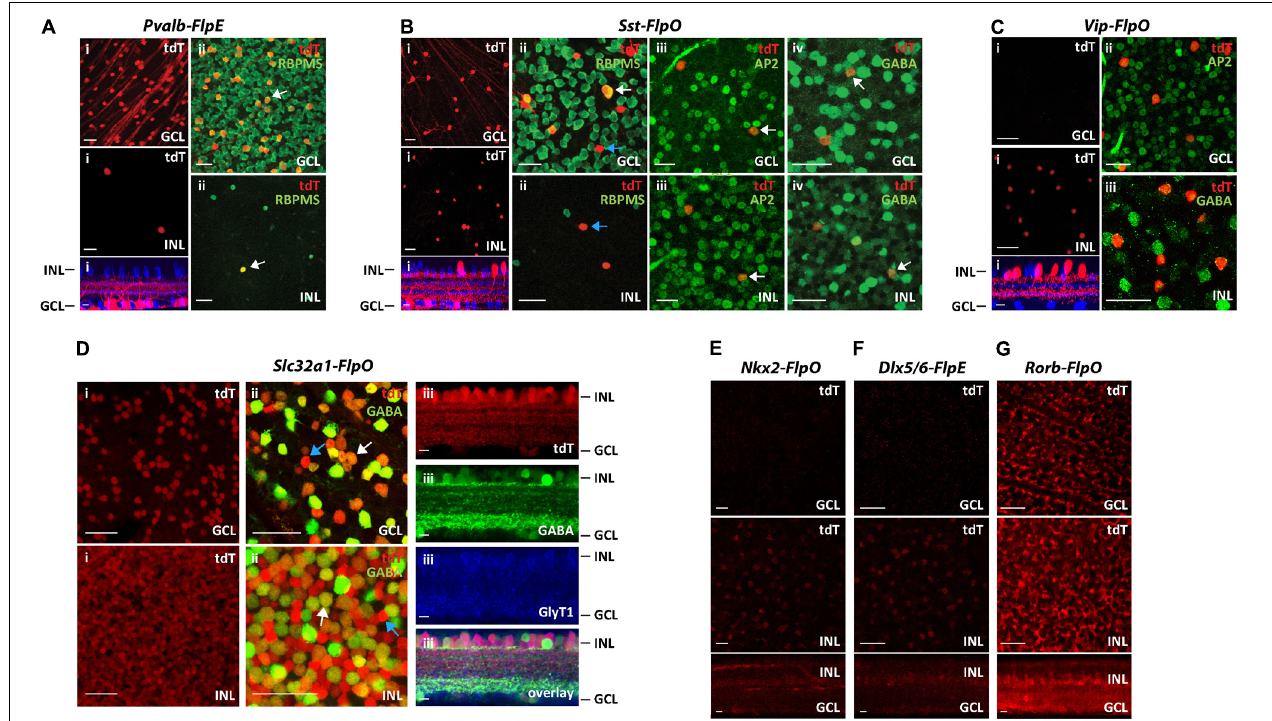
FIGURE 2 | Distribution of FLP-expressing cells in 7 Flp drivers. Each Flp driver was crossed with CMV-Cre and Ai65 mice. (A) Pvalb-FlpE driver. (i) FLPe expressing cells labeled with tdTomato (tdT, red) were observed in the GCL (top) with only a few cells in the INL (middle). Bottom: side view with ChAT (blue). (ii) Staining for the RGC marker RBPMS (green) confirmed that all of the tdTomato-labeled cells (tdT, red) in the GCL and the INL were RGCs. White arrows point to example cells that express RBPMS. (B) Sst-FlpO driver. (i) tdTomato-labeled cells were distributed in both the GCL (top) and the INL (middle). Bottom: side view with ChAT (blue). (ii) RBPMS staining (green). SST + RGCs were found in the GCL, but not in the INL. White arrow indicates a RBPMS + cell (RGC), blue arrow indicates a RBPMS - cell (presumably an amacrine cell). (iii) An amacrine cell marker, AP-2 (green) overlaps with SST + amacrine cells in both the GCL and the INL. White arrows indicate example cells that express AP2. (iv) GABA staining (green). White arrows indicate example cells expressing GABA. SST + amacrine cells in both GCL and INL were GABAergic. (C) Vip-FlpO driver. (i) A majority of the targeted cells (red) in the Vip-FlpO driver were located in the INL (middle). Bottom: side view with ChAT (blue). These presumptive GABAergic amacrine cells were positive for both AP2 (ii) and GABA staining (iii) . (D) Slc32a1-FlpO driver. (i) Labeling density was high in both the GCL and INL. (ii) Double labeling for tdTomato (red) and GABA (green). In the GCL, ∼ 80% of cells were GABAergic, whereas in the INL, ∼ 50% of tdT cells were GABAergic. Examples of GABAergic and non-GABAergic cells (presumably glycinergic amacrine cells) are indicated by white and blue arrows, respectively. (iii) Vertical sections showed that tdTomato-labeled cells were either GABAergic (green, GABA staining) or glycinergic (blue, GlyT1 staining). (E,F) Nkx2-FlpO driver (E) and Dlx5/6-FlpE driver (F) showed very little labeling in both the GCL and the INL. (G) Rorb-FlpO driver showed broad labeling in the GCL and INL, with the strongest labeling in Müller cells. Scale bar, 40 µ m for flat-mount view, 10 µ m for side